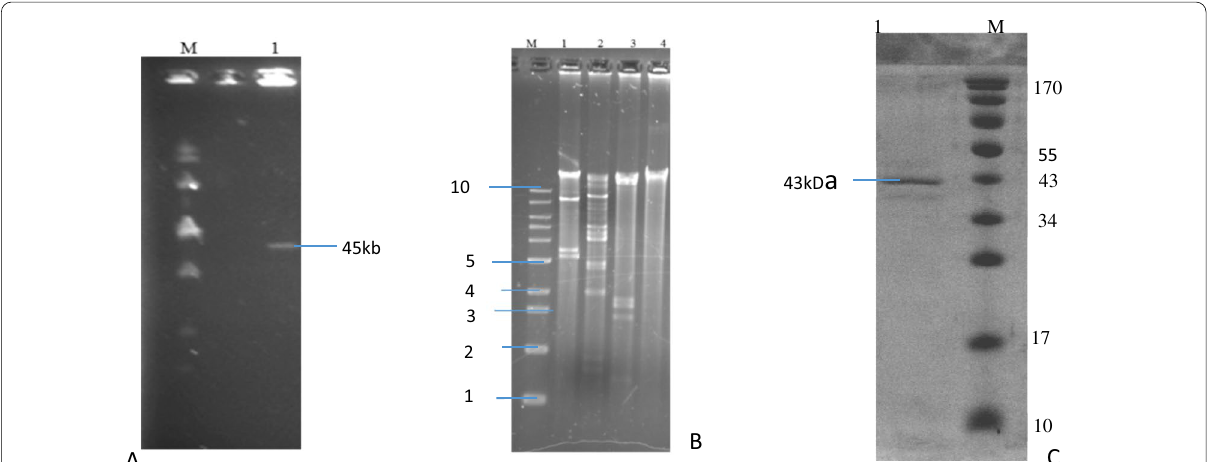
Fig. 3 A The ɸ ParuNE1 phage genome as detected by agarose (1%) gel electrophoresis. Lane M shows a high-range DNA ladder (Gene Ruler), and lane 1 shows a band of phage DNA having a size of approximately 45 kb. B Lane M shows a 1 kb DNA ladder (New England Biolabs), and lane 1, 2 and 3 shows the ɸ ParuNE1phage DNA restriction analysis with EcoR1, EcoRv and Hind III, while lane 4 is uncut DNA. C Lane M shows broad range protein molecular weight markers (10–170 kDa) (BIO-RAD, USA) and lane 1 shows the ɸ ParuNE1 phage protein, 43 kDa.